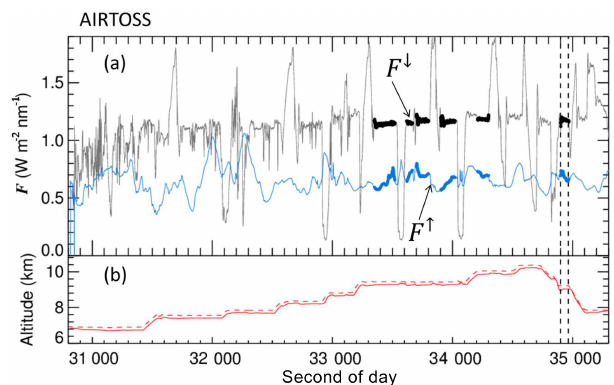
Figure 6. (a) Time series of downward (gray) and upward (light blue) irradiance F (Wm − 2 nm − 1 ) measured on AIRTOSS at one wavelength (550nm) from the flight of 30 August 2013. The thick- ened line periods mark the measuring points at straight flight legs. The red lines in (b) show the altitude of AIRTOSS (solid) and Lear- jet (dashed). The vertical dashed lines mark the period of the mea- surement example in Fig.